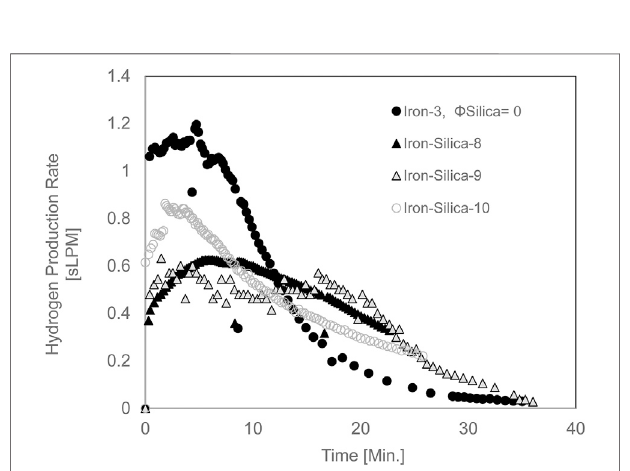
FIGURE 10 | The Hydrogen production rate for mixed iron and silica (45 – 106 µm) with 0.67 silica volume fractions at 950 ° C set furnace temperature, pure iron furnace set temperature is 850 °